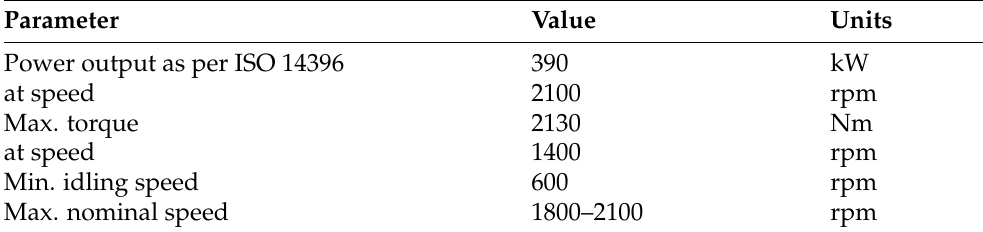
Figure 1. The LHD vehicle under investigation: LKP-1701 (KGHM ZANAM) with a powerful diesel engine for the underground mines [29]. Table 1. Parameters of DEUTZ TCD 12.0 V6 diesel engine